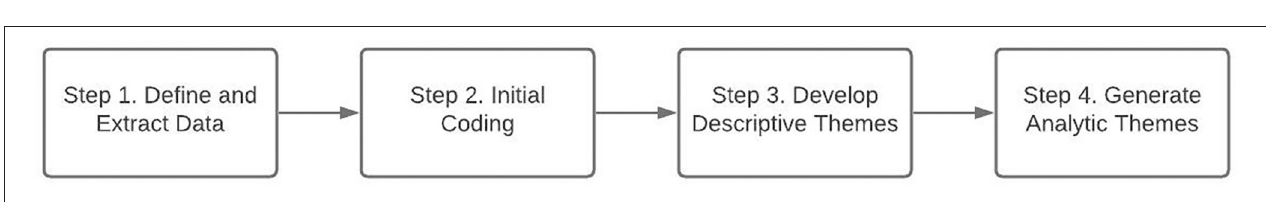
FIGURE 3 | Thematic synthesis process, adapted from Thomas and Harden